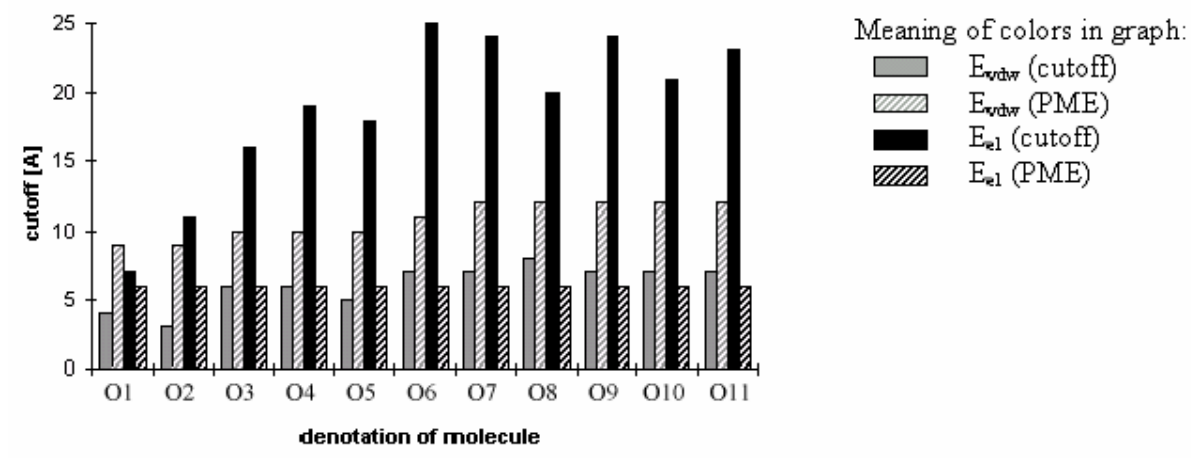
Figure 6. Dependency of energy on cutoff (for oligonucleotide O11). For energy error definition see Fig. 1.